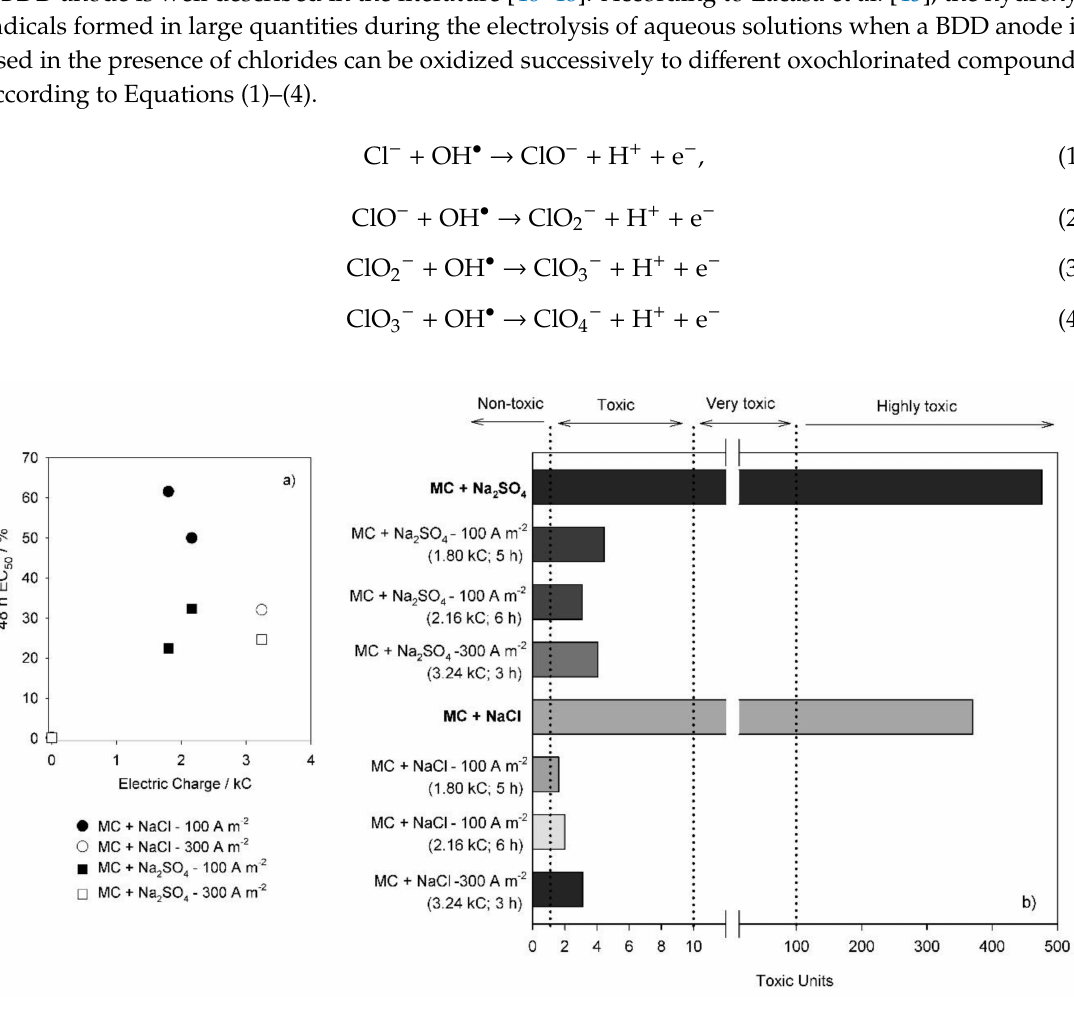
Figure 3. ( a ) EC 50 results obtained for the treated solutions at 100 and 300 A m − 2 using Na 2 SO 4 or NaCl as the supporting electrolyte. ( b ) Comparison of the toxicity of the di ff erent methiocarb solutions in terms of toxic units before and after treatment at the di ff erent experimental